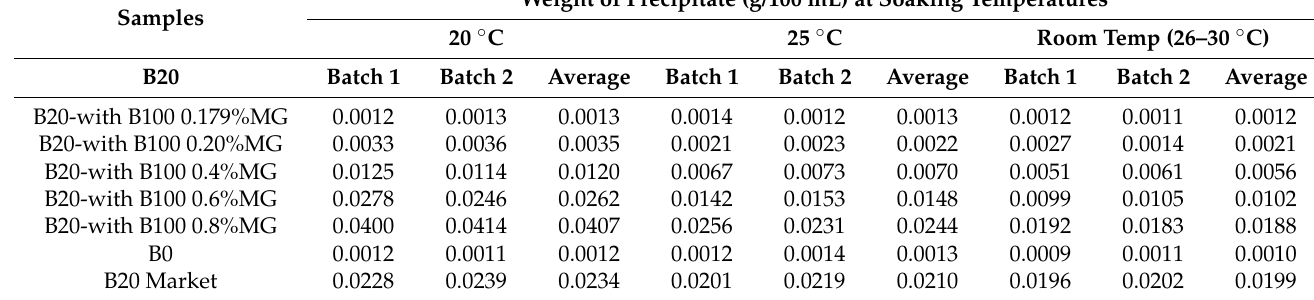
Table 6. Result of precipitation